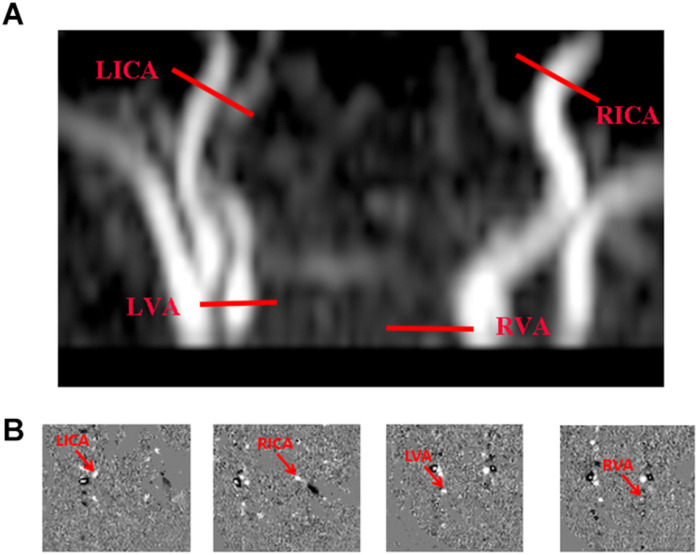
Cerebral blood flow determination via phase-contrast (PC) MRI. (A) Slice positions overlaid on angiogram image (each red bar indicating imaging slice of one PC MRI scan), performing four PC MRI scans in each subject to assess internal carotid arteries (left, LICA; right, RICA) and vertebral arteries (left, LVA; right, RVA), respectively; and (B) Corresponding PC MRI images (delayed).